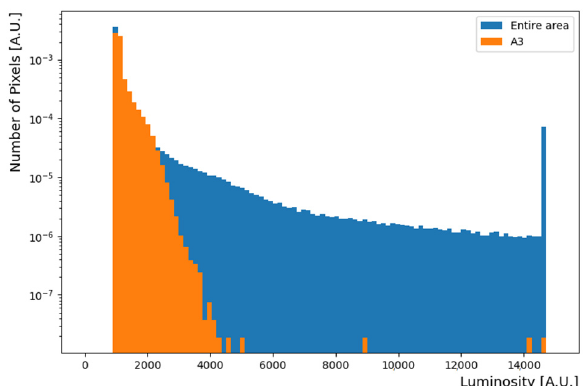
Figure 6. Charge distribution of all the pixels in the raw images. When its value was not normalized, the maximum charge value is 14,605 in each pixel. The minimum value for dark regions starts at 1000. The rightmost value is the case when a large amount of light enters. Blue color indicates the charge distribution of all the regions, and orange shows the charge distribution of the only the A4 region and sub sample of all the regions.